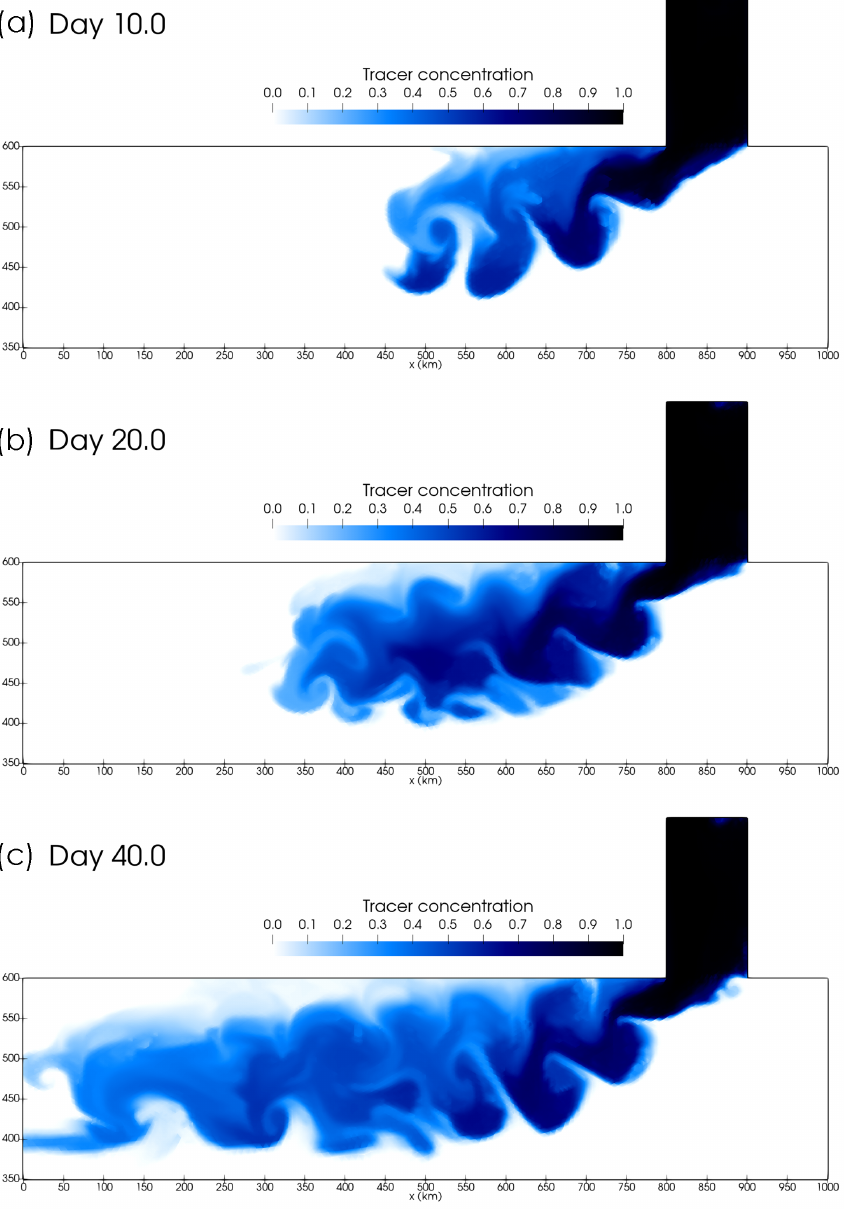
Figure 9. Bottom tracer concentration in the DOME test case after 10 (a) , 20 (b) , and 40 days (c)